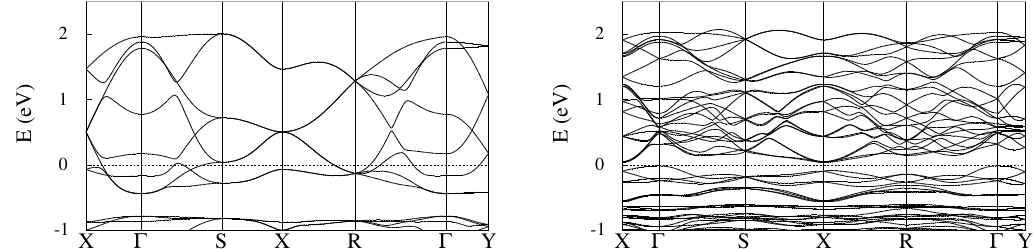
Figure 6: Calculated band structures of the nonmagnetic Pnma YNiO disproportionated antiferromagnetic P -type YNiO wave vector ( 1 , 1 ,0 ) . The path is as in Fig. 5. o 2 2